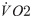
V˙O2 and propulsive force vs distance for the 1900 meters race.V˙O2 (left in green) and propulsive force (right): blue is the propulsive force f(s) in the direction of movement, black is the effective propulsive force ftot=f2+c2v4 taking into account the centrifugal force, where c is the curvature.